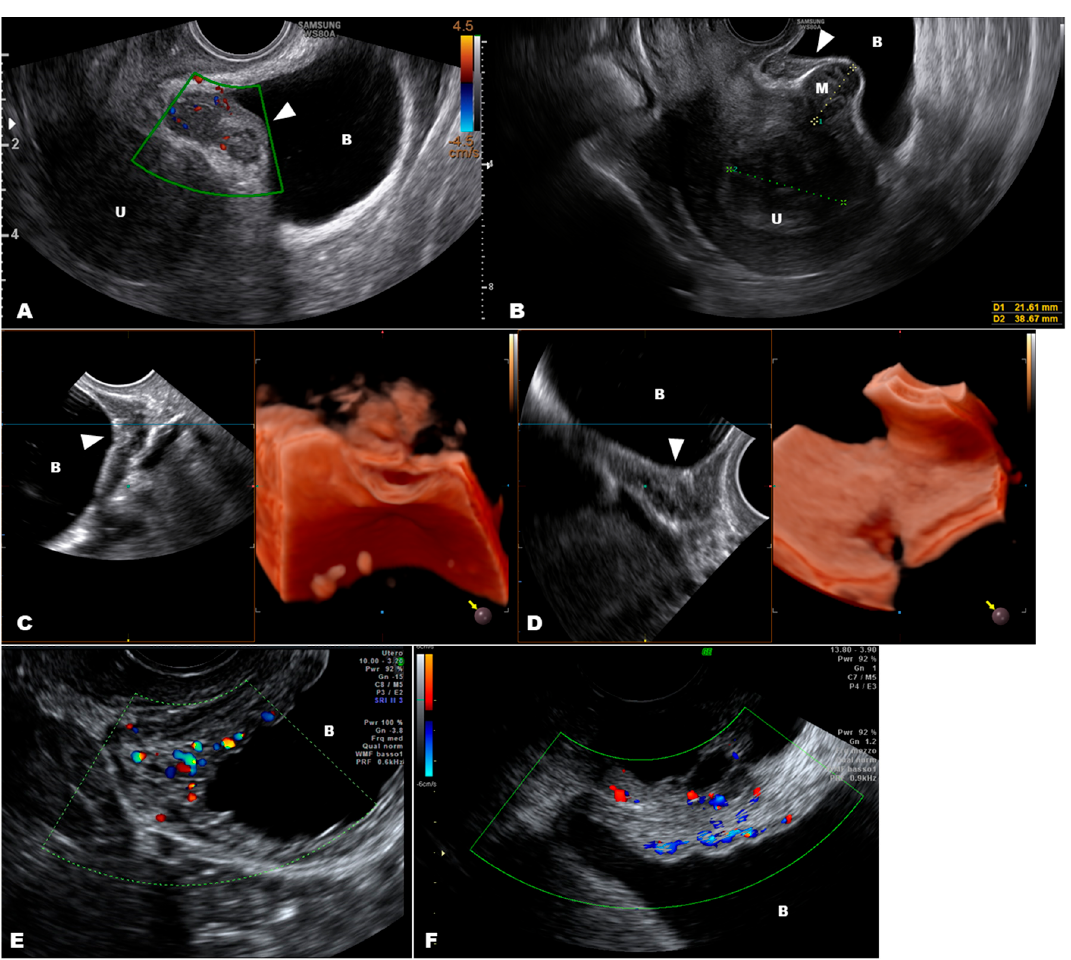
Figure 5. A typical endometriosis nodule (arrow) of the bladder ( A ); figure ( B ) shows a flat nodule of endometriosis (arrow) with a subserosal myoma that distorts the bladder dome; a flat endometriosis nodule (arrow) of the bladder that can be seen at 3D ultrasound only when cut ( C ) while the internal surface of the bladder appears regular ( D ); figure ( E ) shows a thick bladder wall due to cystocele and figure ( F ) in case of recurrent cystitis. Abbreviations: U, uterus; B, bladder; M, myoma.